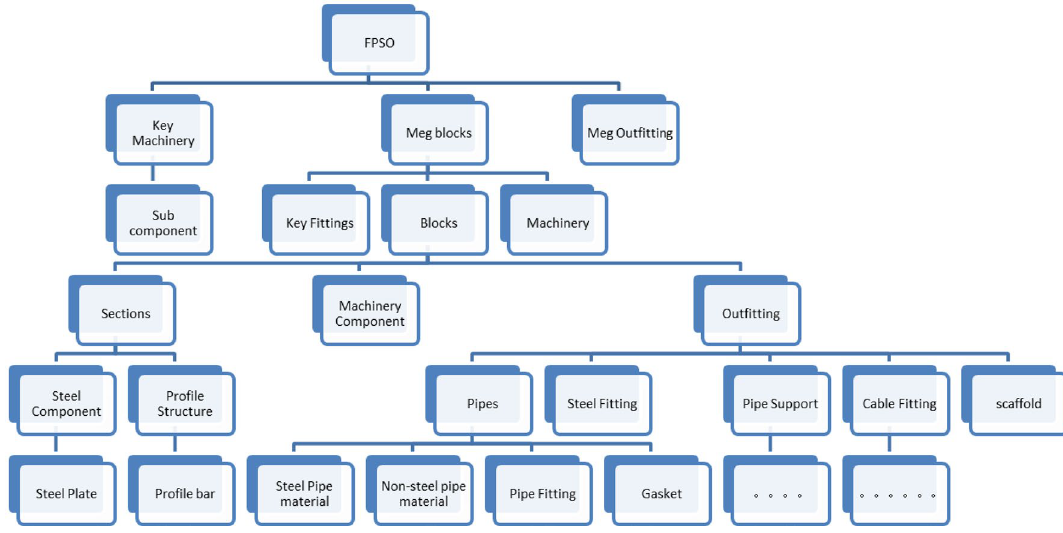
Fig. 3 Structure of shipbuilding